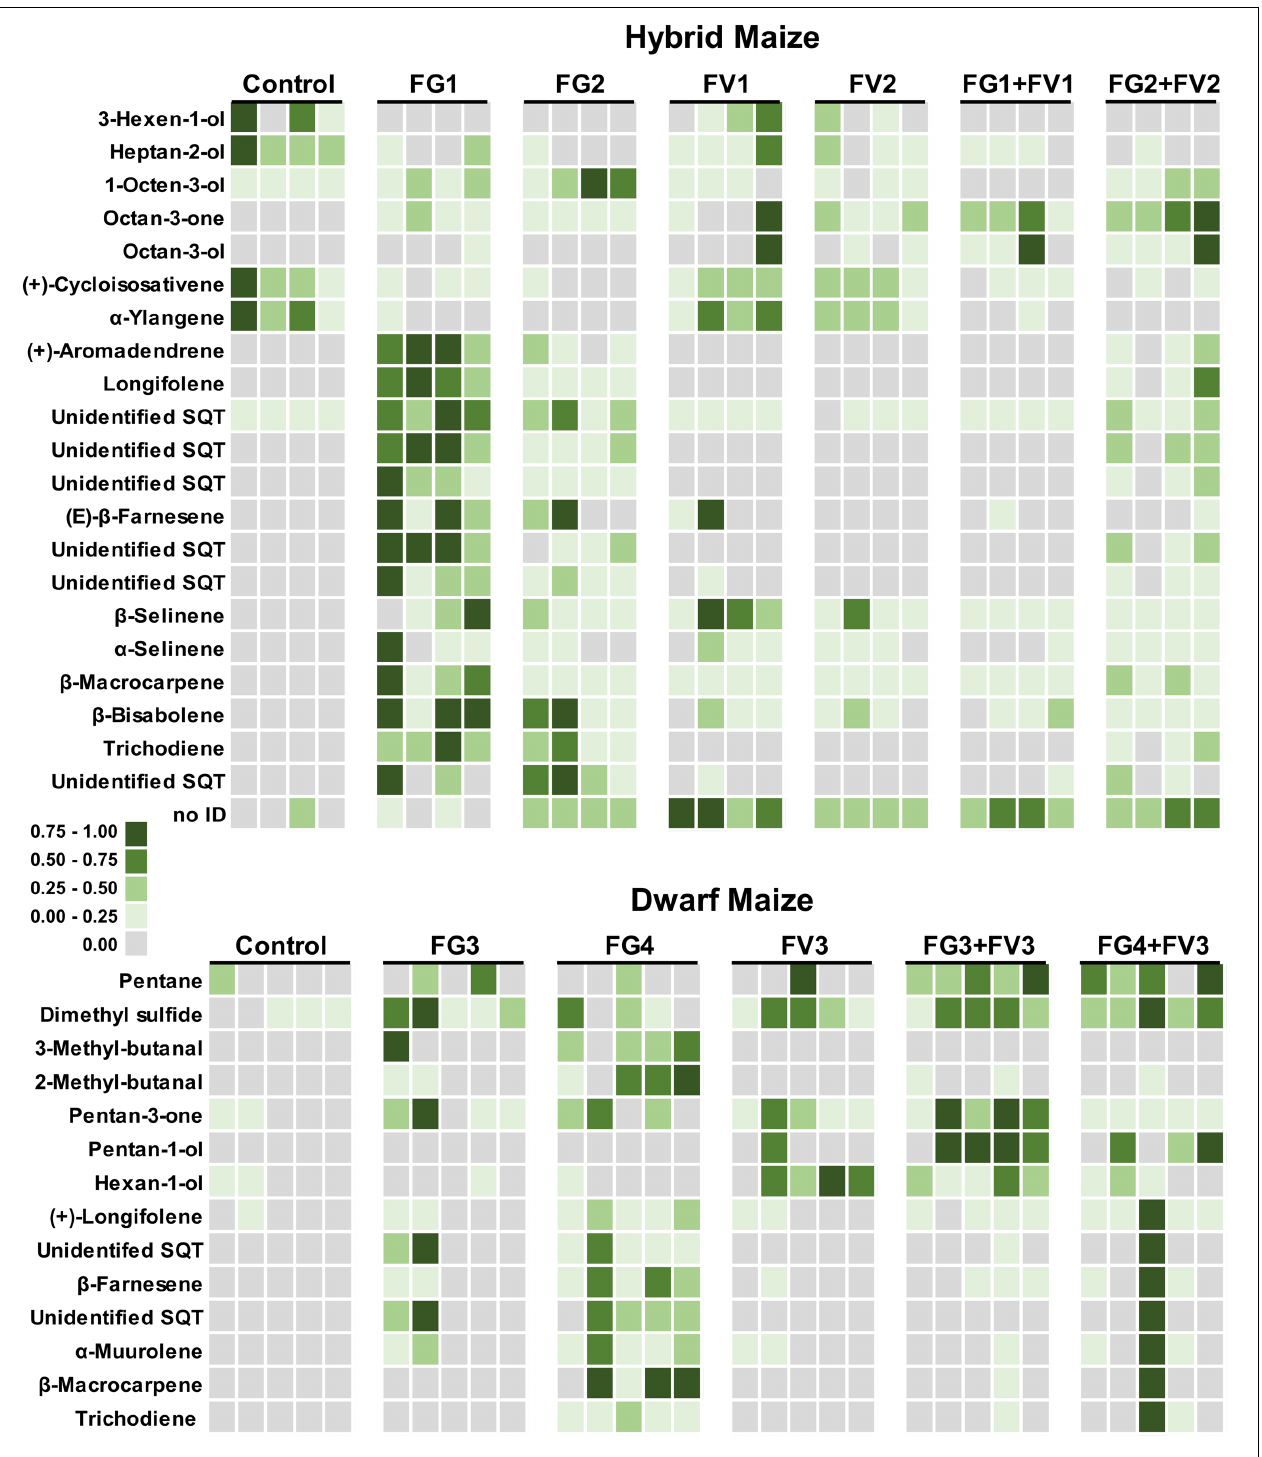
FIGURE 5 | Heatmap representing volatiles that are regulated in dwarf and hybrid maize upon infection with Fusarium . Squares correspond to the concentration of single volatiles emitted from independent ears for each treatment – dwarf maize, n = 5 replicates per treatment; hybrid maize, n = 4 replicates per treatment. Squares have been color coded to represent volatile concentrations (normalized from zero to one). The heatmap illustrates that volatiles are differentially regulated by single inoculations or co-inoculations of Fusarium strains. Treatments: Control, uninfected ears; FV, F. verticillioides ; FG, F. graminearum. Refer to Table 1 for details about strain numbers. For hybrid maize, part of the data (control and single inoculations with FG1 and 2 and FV1 and 2) has already been described in Becker et al., 2014. The data is shown here for consistency with dwarf maize and for allowing the comparison to co-inoculations.